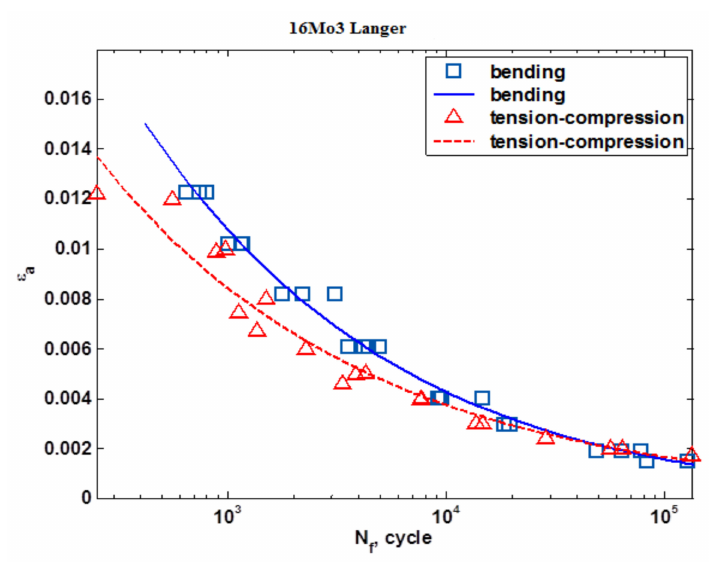
Figure 10. The strain characteristic according to the Langer model.